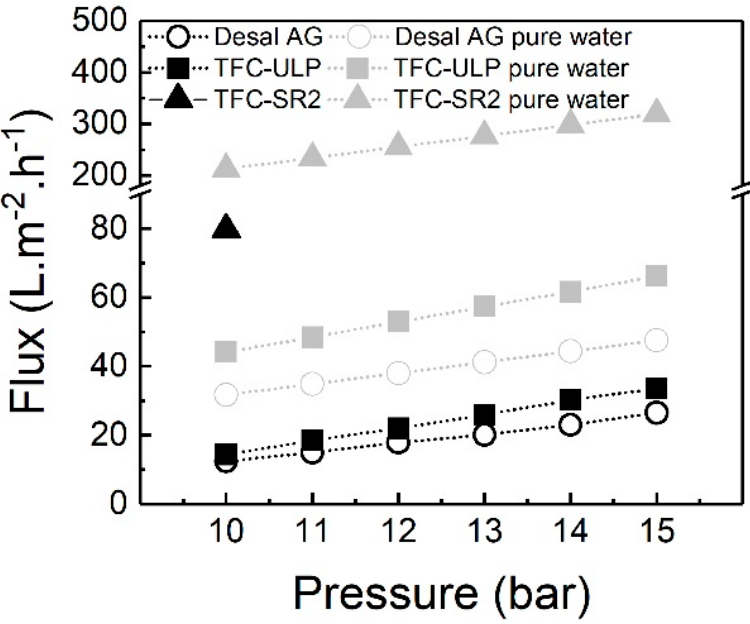
Figure 4. Permeate flux of membranes as a function of applied pressure (10–15 bar) with groundwater sample 5, the pH was about 9, data adapted from [69]; light grey data points are pure water flux of membranes based on the pure water permeability in Table 2.